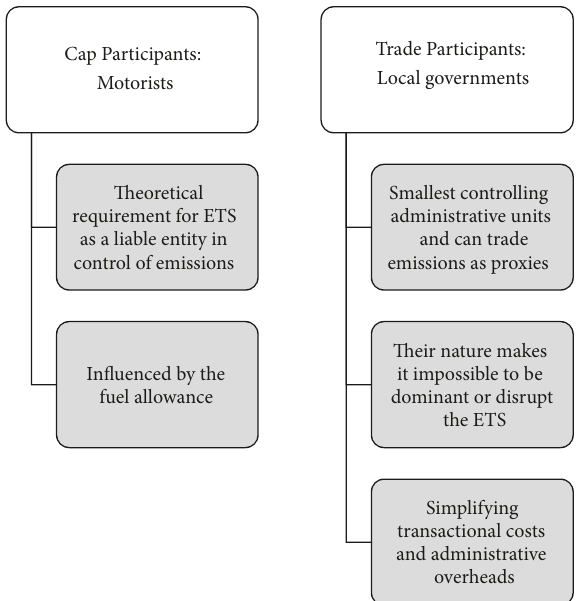
Figure 1: Significance of separating the “cap” and “trade” participa-